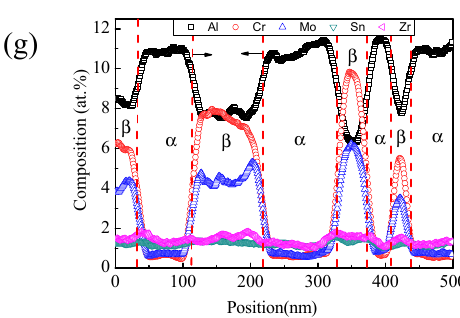
Figure 8. Microstructure and local composition mapping in the sample cooled to 893 K: ( a ) HAADF, ( b ) Al, ( c ) Cr, ( d ) Mo, ( e ) Sn, ( f ) Zr, and ( g ) composition profiles along the red line in ( a ).